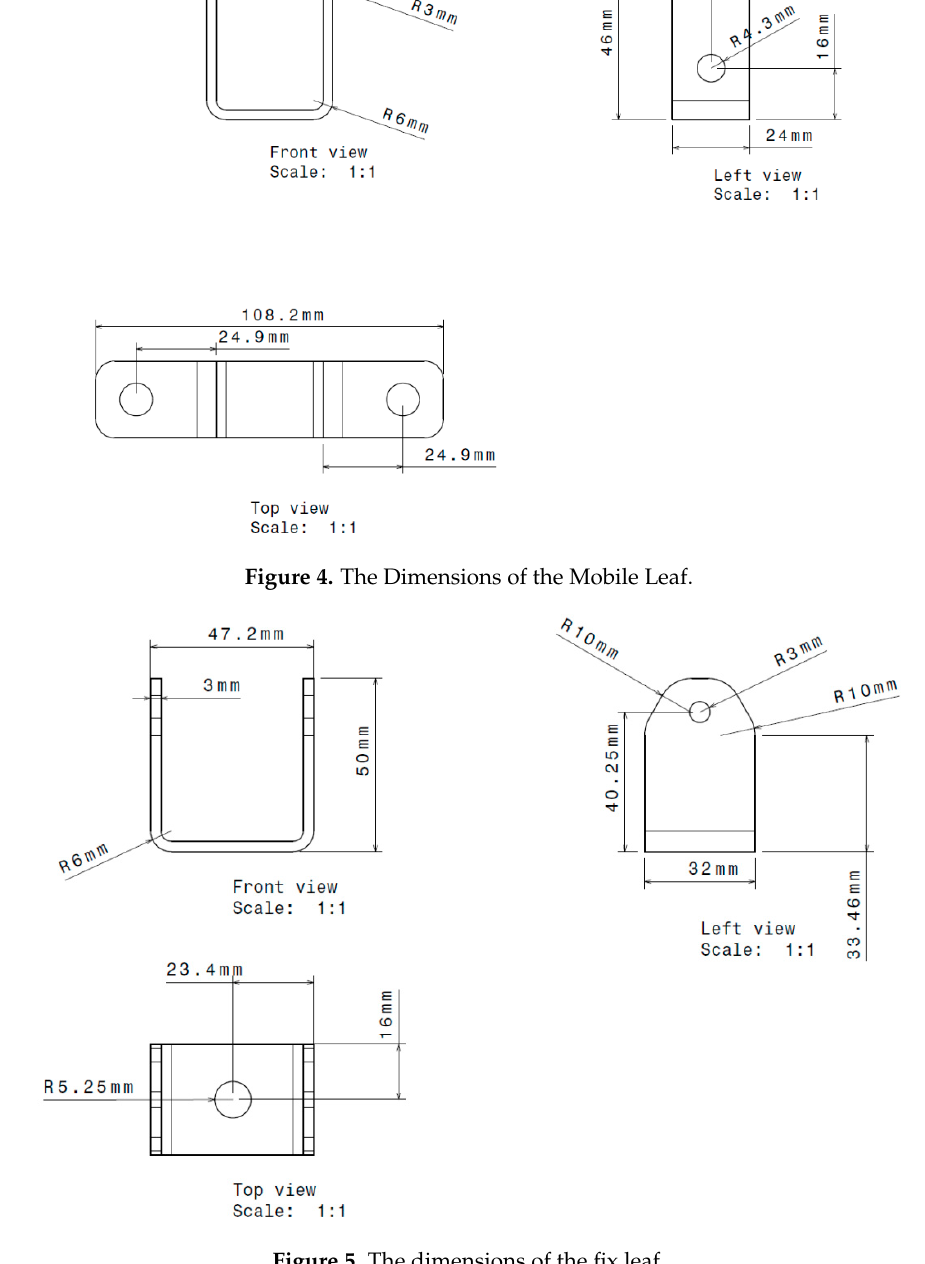
Figure 5. The dimensions of the fix leaf.